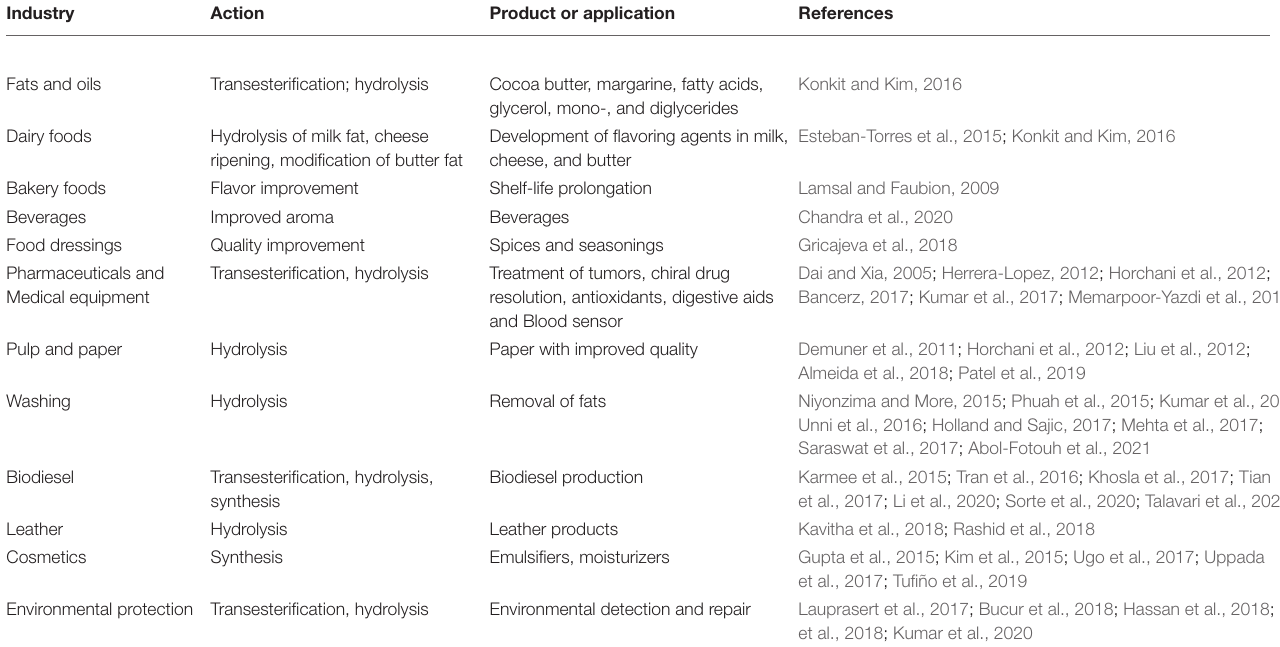
TABLE 2 | Industrial applications of microbial